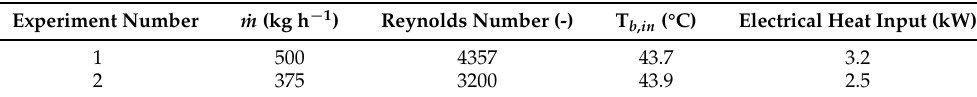
Table 3. The operational parameters used for the initial testing of the phase change